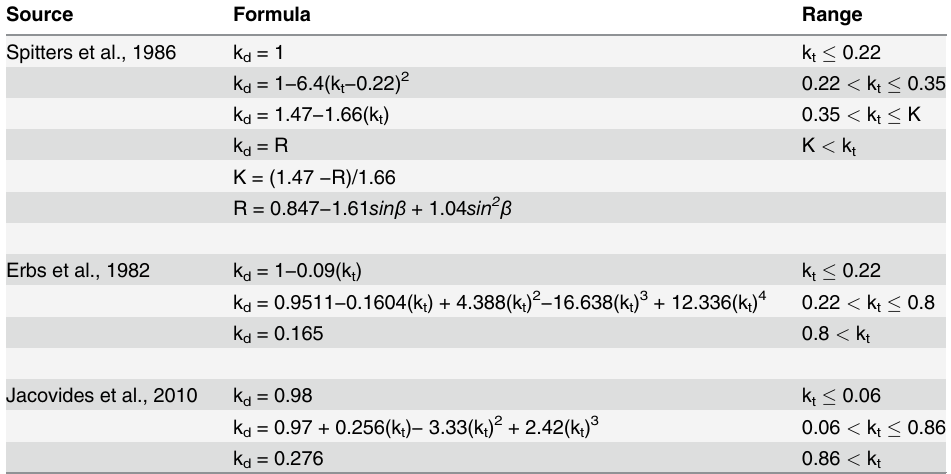
Table 3. Empirical formulas. Source